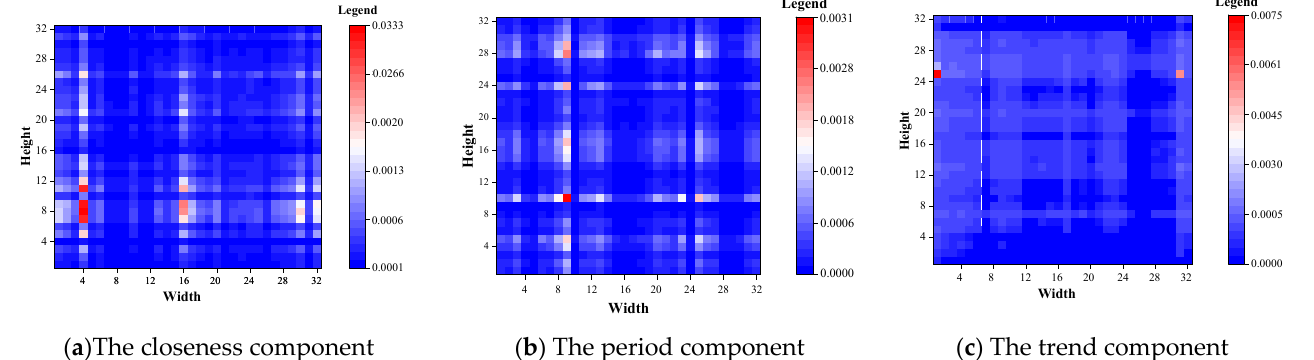
Figure 10. Visualization of FSA module for TaxiBJ dataset .